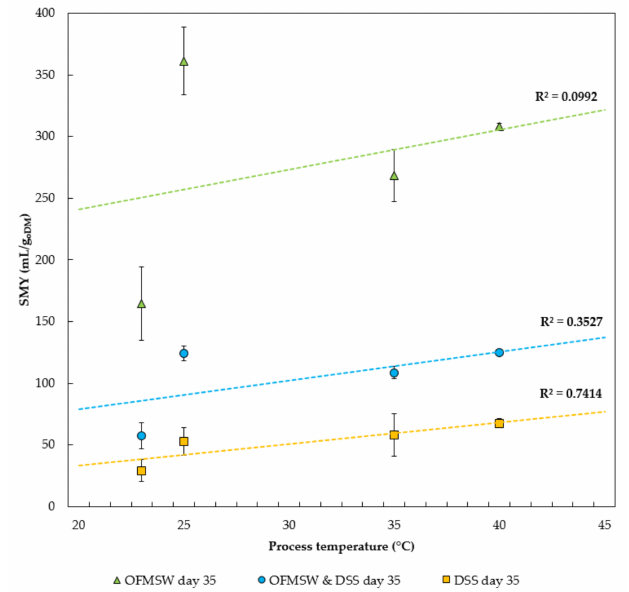
Figure 4. Specific methane yield (SMY) on day 35 of the experiment based on organic dry matter (oDM) for the organic fraction of municipal solid waste (OFMSW) and digested sewage sludge (DSS) alone and in the mixture. Gas volume at 1013 hPa, 0 ◦ C; mean values ± standard deviation including trend lines with n = 2 for DSS, n = 4 for OFMSW, n = 4 for OFMSW and